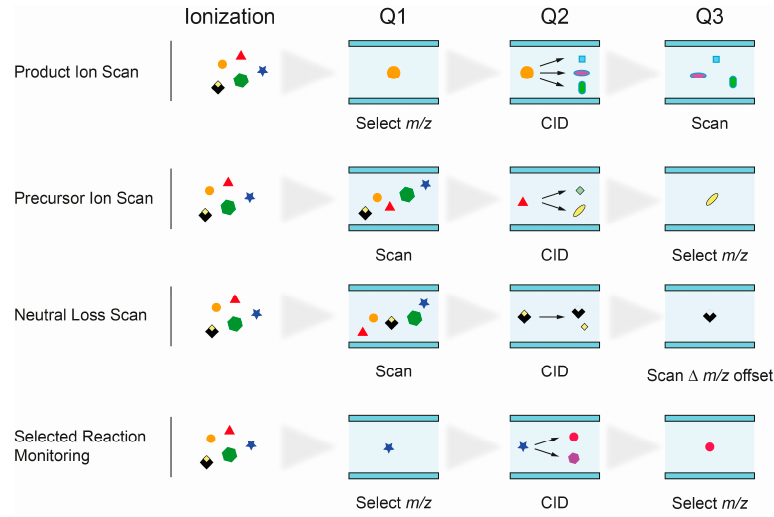
Figure 3. Schematic illustration of scan modes used on triple quadrupole mass spectrometers. Q, Quadrupole; CID, collision induced dissociation.